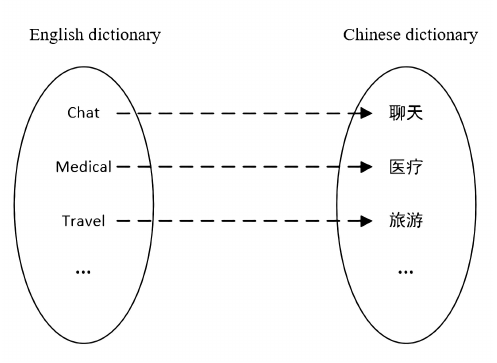
Figure 4. Chinese–English dictionary mapping process of service category.